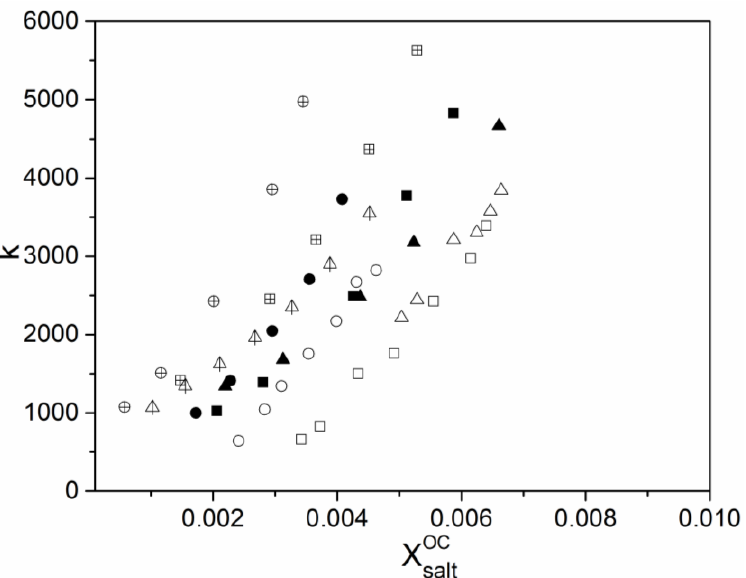
Figure 2. Partition coefficients versus salt molar fraction in OC for the systems containing sodium citrate at 283.2 K (o) 293.2 K (●), and 303.2 K ( ⊕ ); sodium sulfate at 283.2 K (□), 293.2 K ( ■ ), and 303.2 K ( ⊞ ) and sodium tartrate at 283.2 K ( △ ), 293.2 K ( ▲ ), and 303.2 K ( ⏃ ).